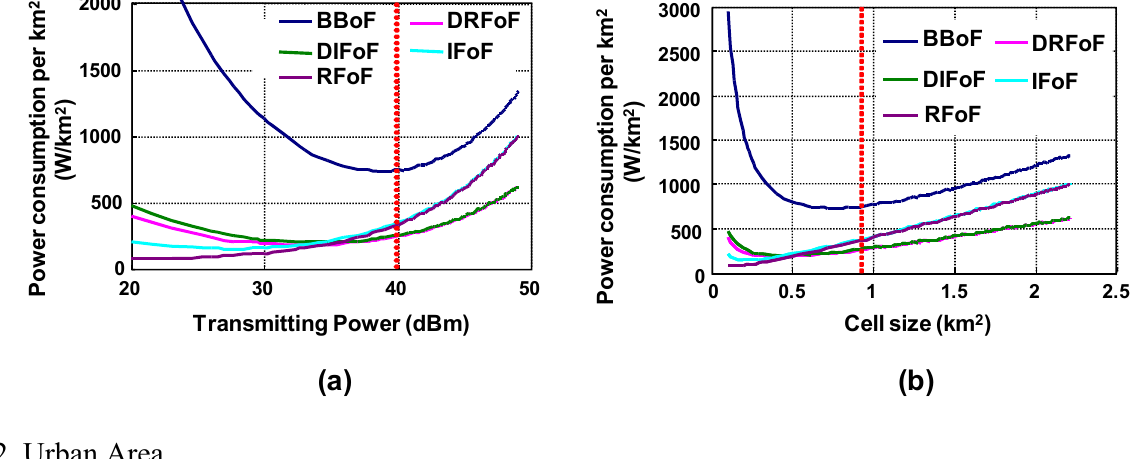
Figure 10. Power consumption per square km coverage for rural area for the five different transport schemes plotted as a function of ( a ) base station transmitting power and ( b ) cell size (With kind permission from Springer Science and Business Media).